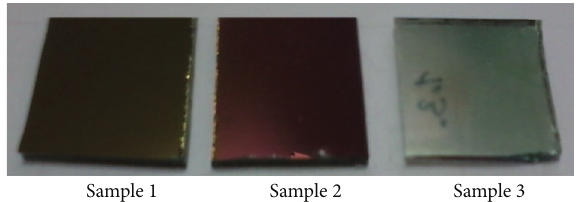
Figure 5: The appearance of Ti 𝑥 O 𝑦